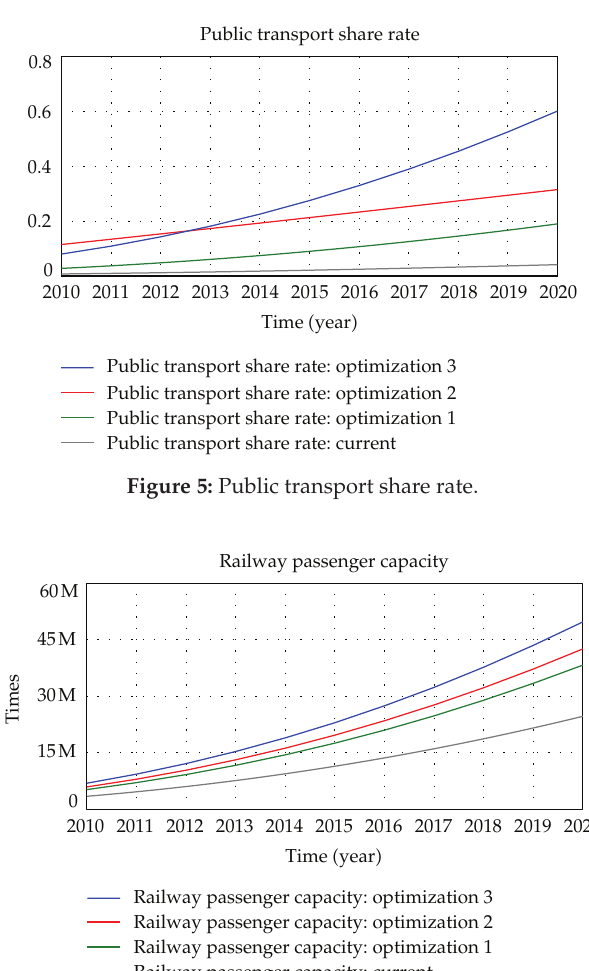
Figure 6: Railway passenger